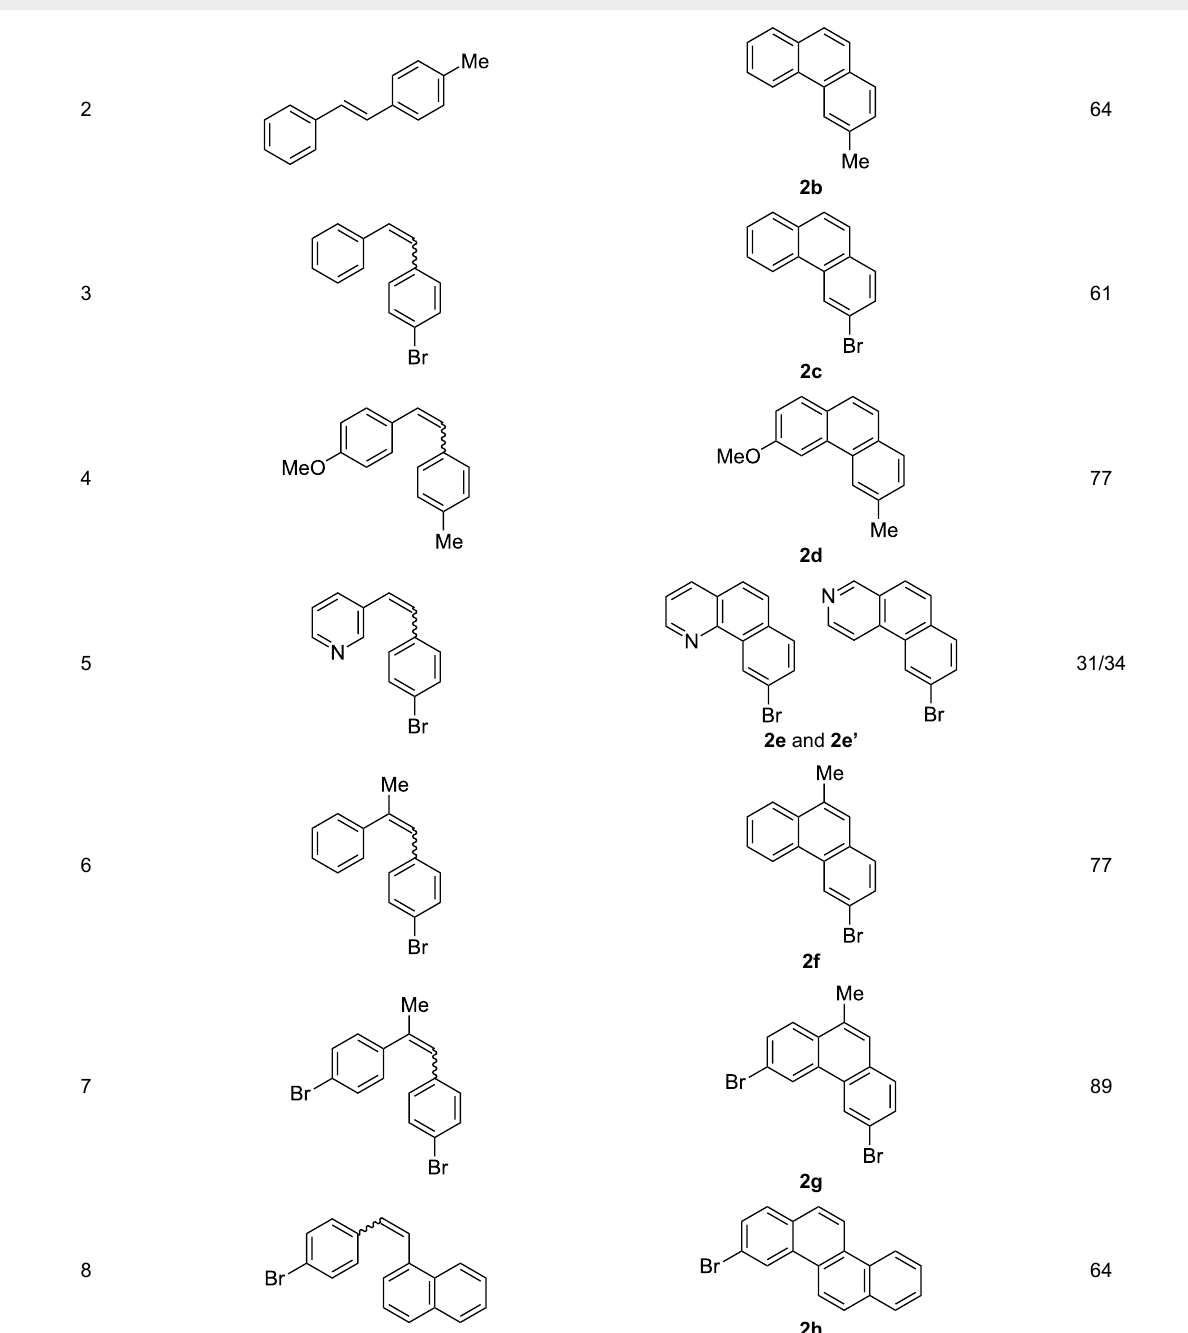
Table 3: Scope of the photocyclization of stilbene derivatives in continuous flow to give substituted phenanthrenes.